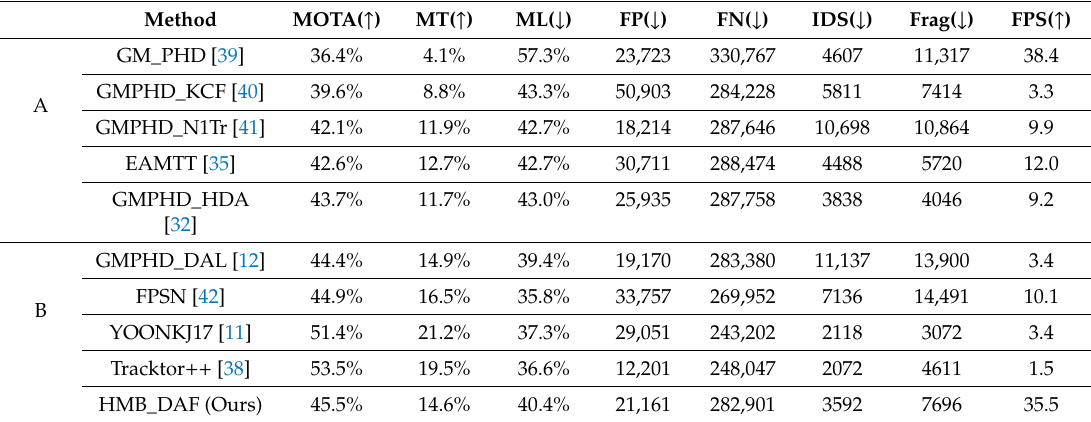
Table 5. Tracking performance on the MOT17 dataset. Best results in each category appear in bold. (A) Traditional method, (B) deep learning method. Our method is denoted by